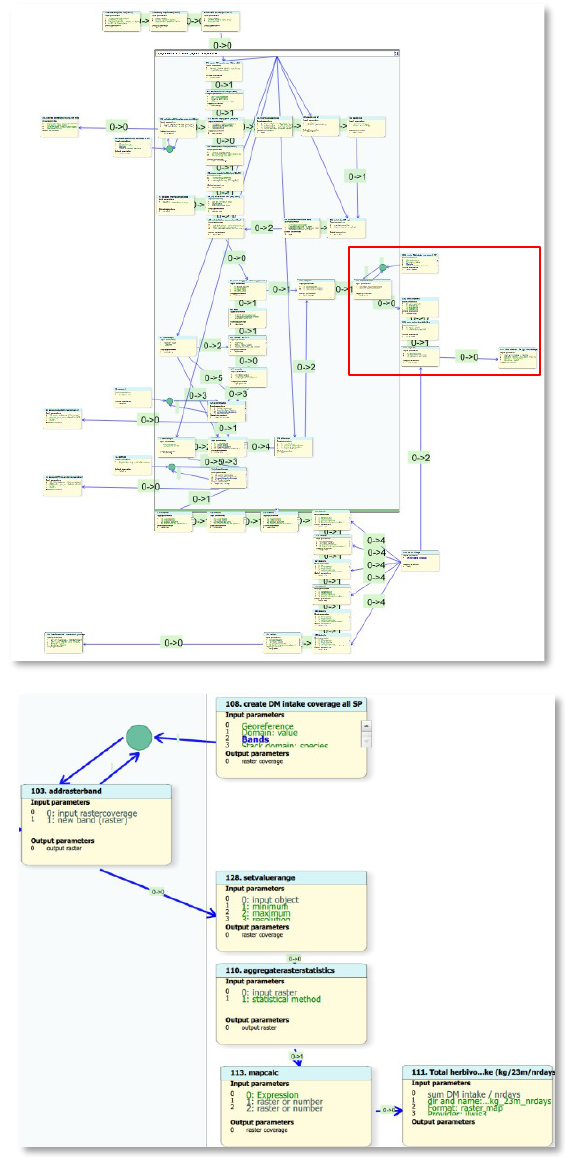
Figure 6. The ILWIS 4 demand workflow (overall and an enlarged part)